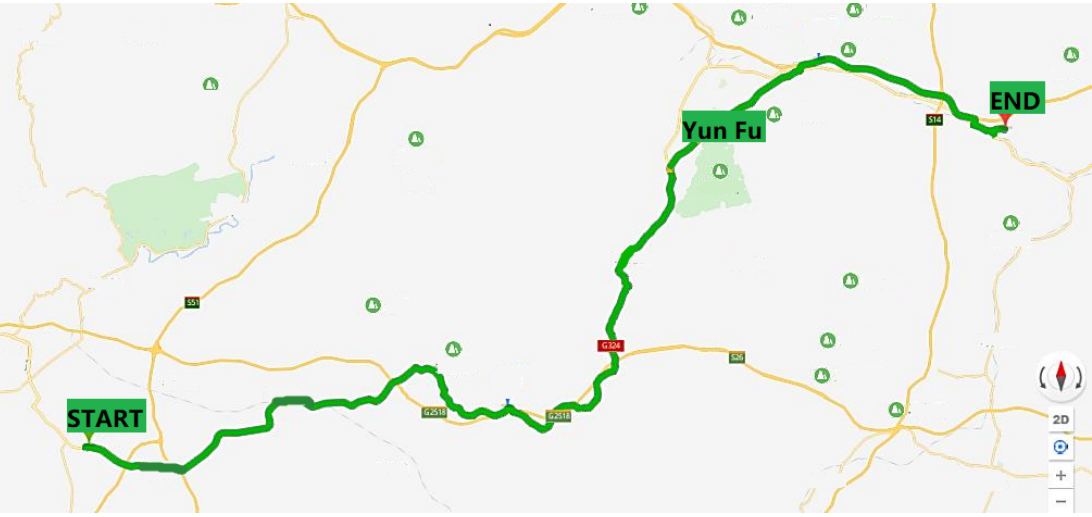
Figure 2. The selected driving route.